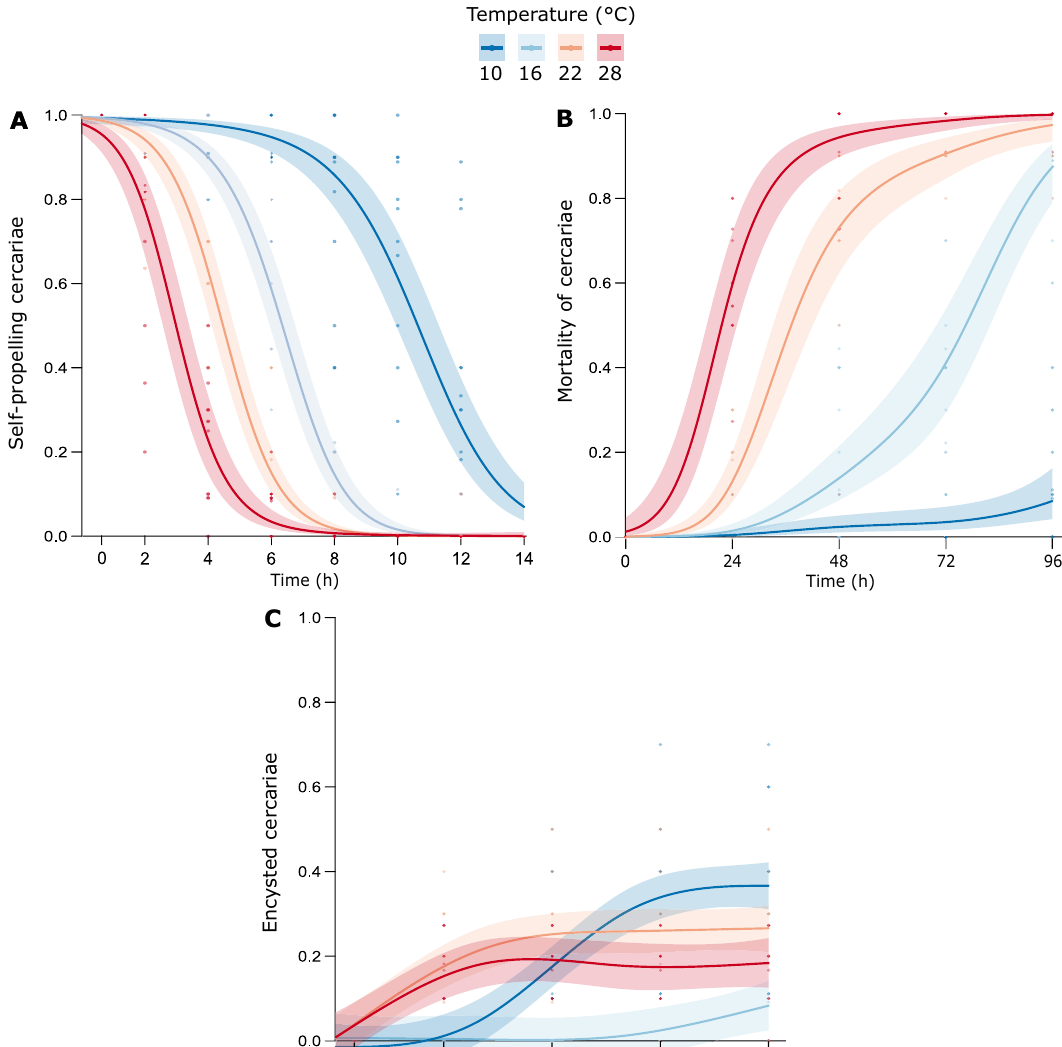
Figure 4. Generalized additive mixed models of Himasthla elongata cercariae activity ( A ), mortality ( B ), and encystment ( C ) with temperature (°C) and time (h) as smooth terms. Models explain 87%, 85%, and 78% of the response variance,